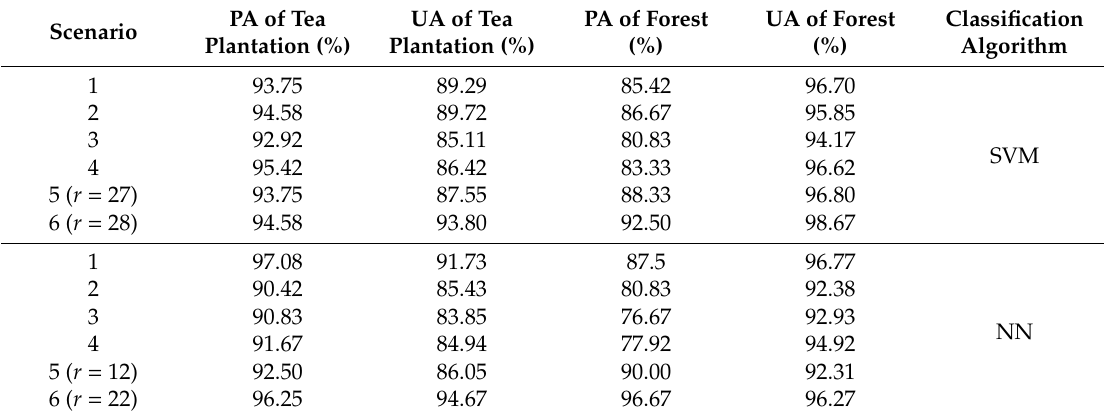
Table 6. Producer accuracy (PA) and user accuracy (UA) of tea plantations and forests with support vector machine (SVM) and neural network (NN) algorithms for different scenarios.